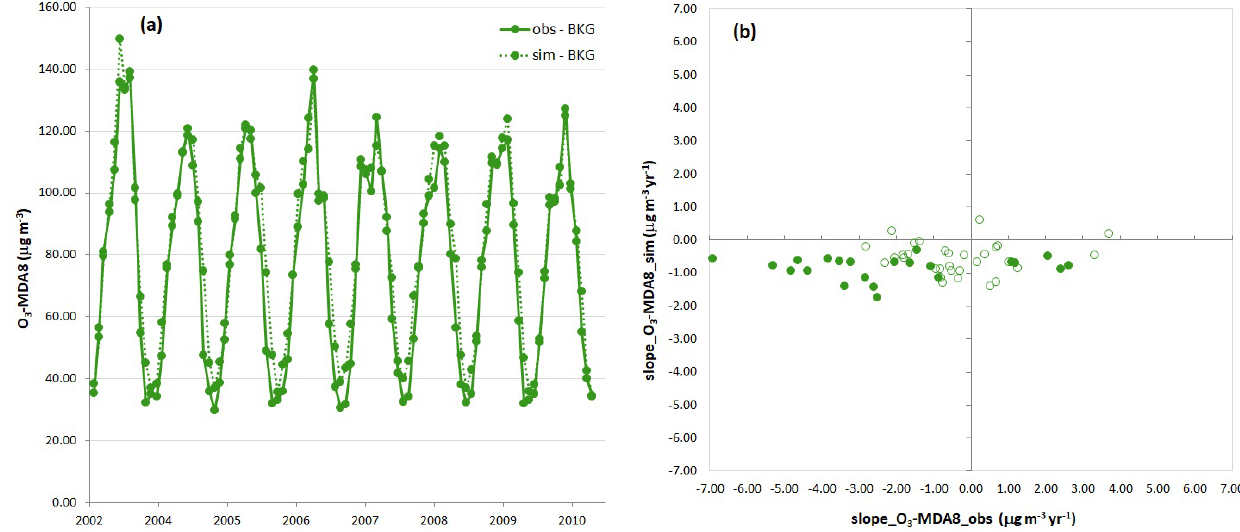
Figure 12. (a) Observed (solid line) and simulated (dashed line) monthly means of O 3 MDA8 concentrations (in µgm − 3 ) for all the back- ground monitoring stations. (b) Scatter plot of observed and simulated slopes (in µgm − 3 yr − 1 ) for O 3 MDA8 in the period April–September at each individual station. Sites where significant slopes are estimated for both observations and simulated data are indicated with a filled symbol.